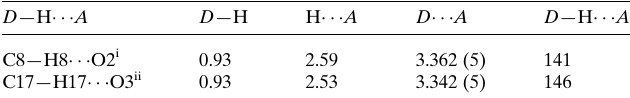
Table 1 Hydrogen-bond geometry (A˚ , (cid:2)